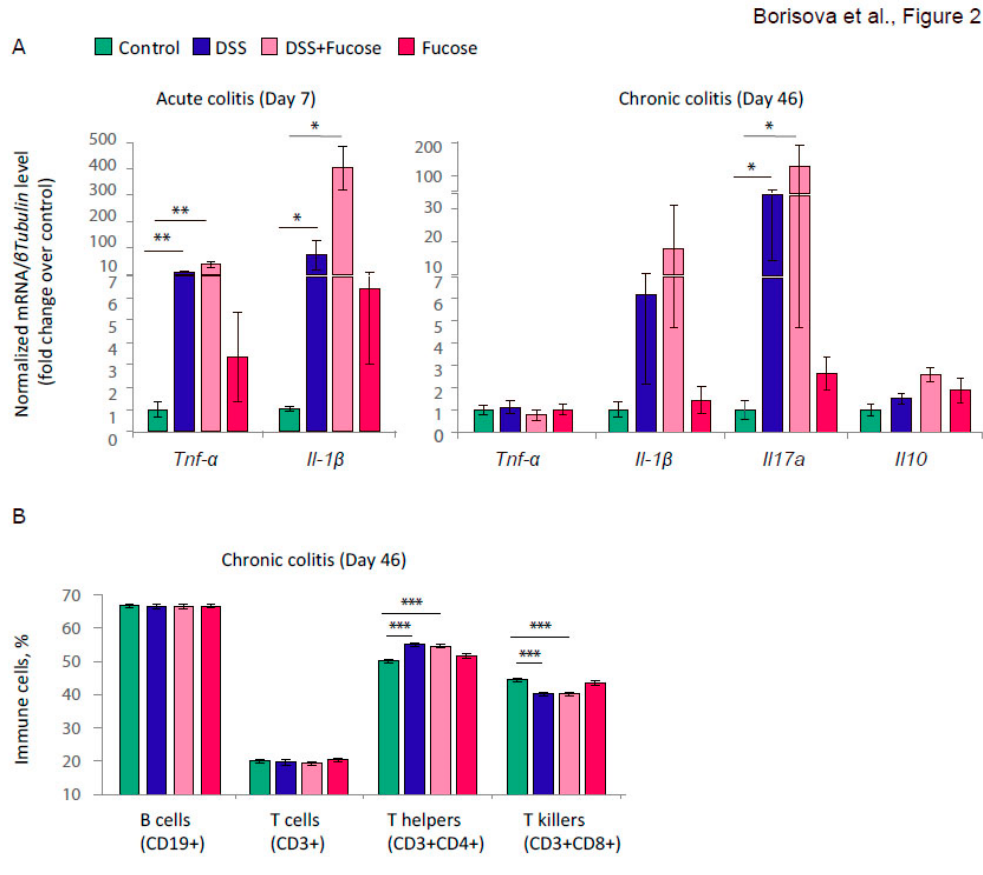
Figure 2. Fucose addition does not affect proinflammatory cytokine gene expression and blood immune cells. ( A ) Expression of cytokine genes in the descending colon normalized on the β Tubulin ( Tubb5 ) gene. * = p < 0.05, ** = p < 0.01, Mann-Whitney u -test. ( B ) Percentage of a given immune cell type. CD19 + and CD3 + are shown as percentages of lymphocytes, CD4 + and CD8 + —as percentages of CD3 + lymphocytes. *** = p < 0.001, Student’s t -test for independent samples.